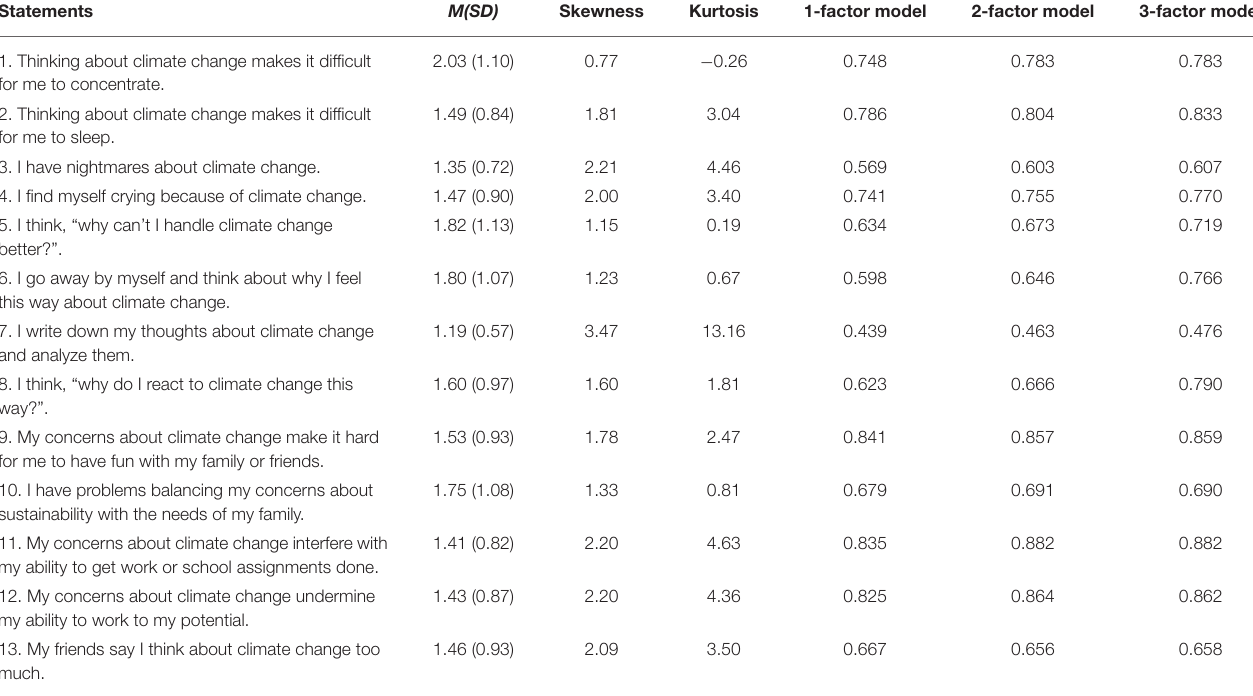
TABLE 2 | Descriptive statistics of the Climate Anxiety Scale (CAS) statements and standardized factor loadings from the confirmatory factor analysis (CFA) [robust maximum likelihood (ML) estimation, all p <